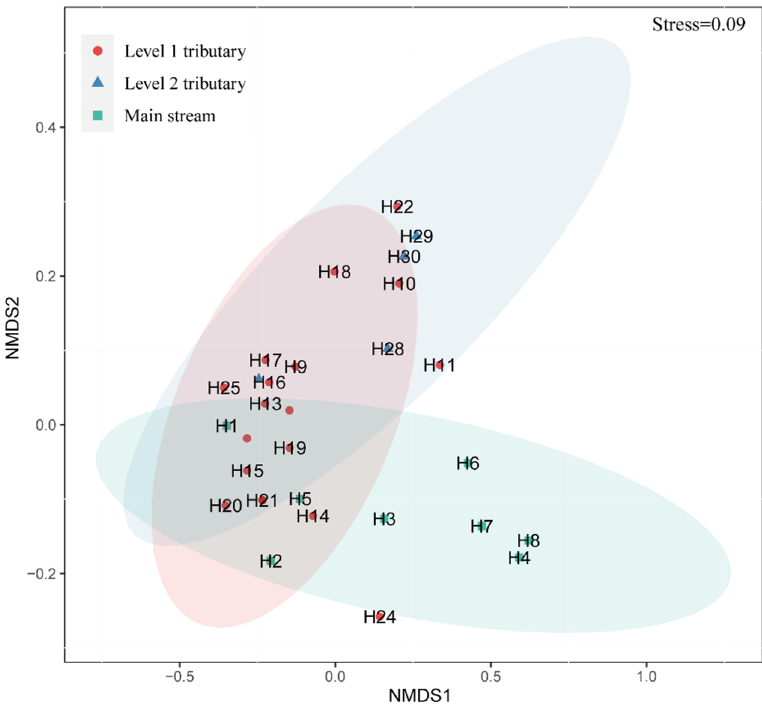
Figure 4. NMDS analysis based on phytoplankton density in the Huaihe River Basin.